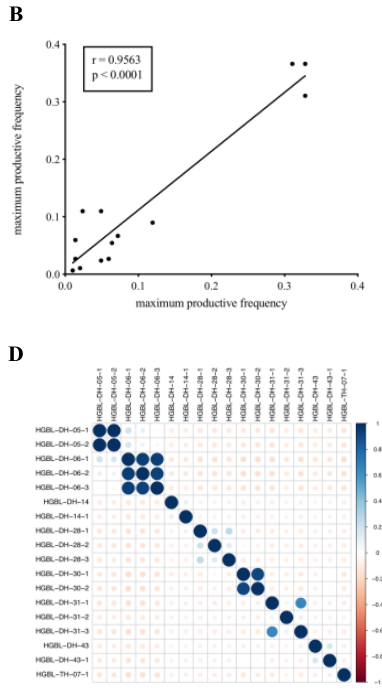
Figure 2. Comparative analysis of multiple samples of a given patient. When analyzing two samples from a given patient derived from separate locations at the same point in time, we found a high degree of correlation according to Pearson’s-correlation with regard to productive-clonality ( A ), maximum-frequency of a productive-clonotype ( B ), percentage of the frequency of the %top10 most expanded TCR-clonotypes ( C ) as well as TCR-sequence overlap as illustrated by a linear heat map of sequence homology ( D